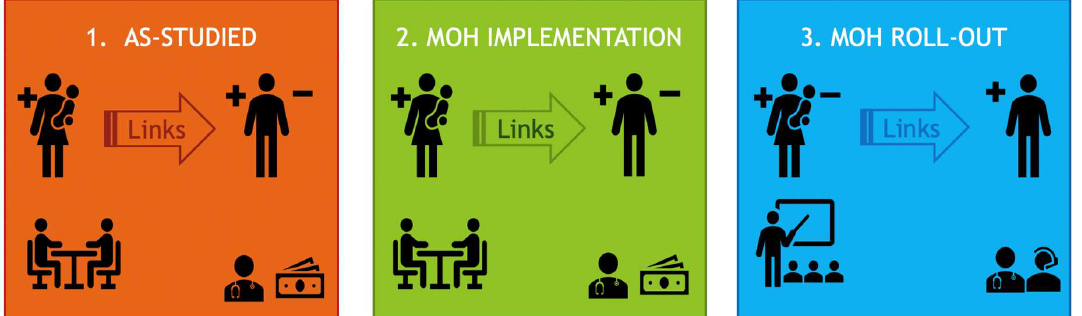
Figure 1. Intervention scenarios.*: The “as-studied” and “MOH implementation” scenarios both assume healthcare staff provides individual counseling with pregnant women living with HIV (PWLHIV) on HIV self-test (HIVST) use and strategies to give tests to their male partners. Regardless of whether males self-test HIV-positive or negative, they are encouraged to link to the clinic for confirmatory testing, counseling, linkage to treatment (if positive), PrEP (if negative), and syphilis testing; all men who attend the clinic receive a travel reimbursement. The “MOH roll-out” scenario assumes provision of group counseling for pregnant women, regardless of HIV status, on how to distribute HIVST kits to their male partners. Male partners are encouraged to link to the clinic only if they self-test positive; men attending the clinic receive confirmatory testing using the dual HIV/Syphilis rapid test, counseling, and linkage to treatment. Men in this scenario are not offered a travel reimbursement. The MOH currently offers toll-free phone counseling for anyone, male or female, interested in using an HIVST kit; therefore, this cost is included in the scenario.